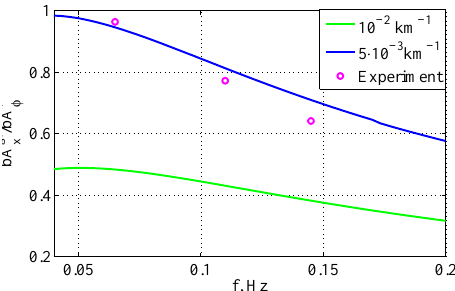
Figure 12. Ground-to-ionosphere amplitude ratio for Alfven waves obtained from the full wave equation with International Reference Ionosphere (IRI) model ionosphere at two different k values (solid lines) and the NUR to CHAMP amplitude ratio, averaged over two months, in three frequency bands (magenta